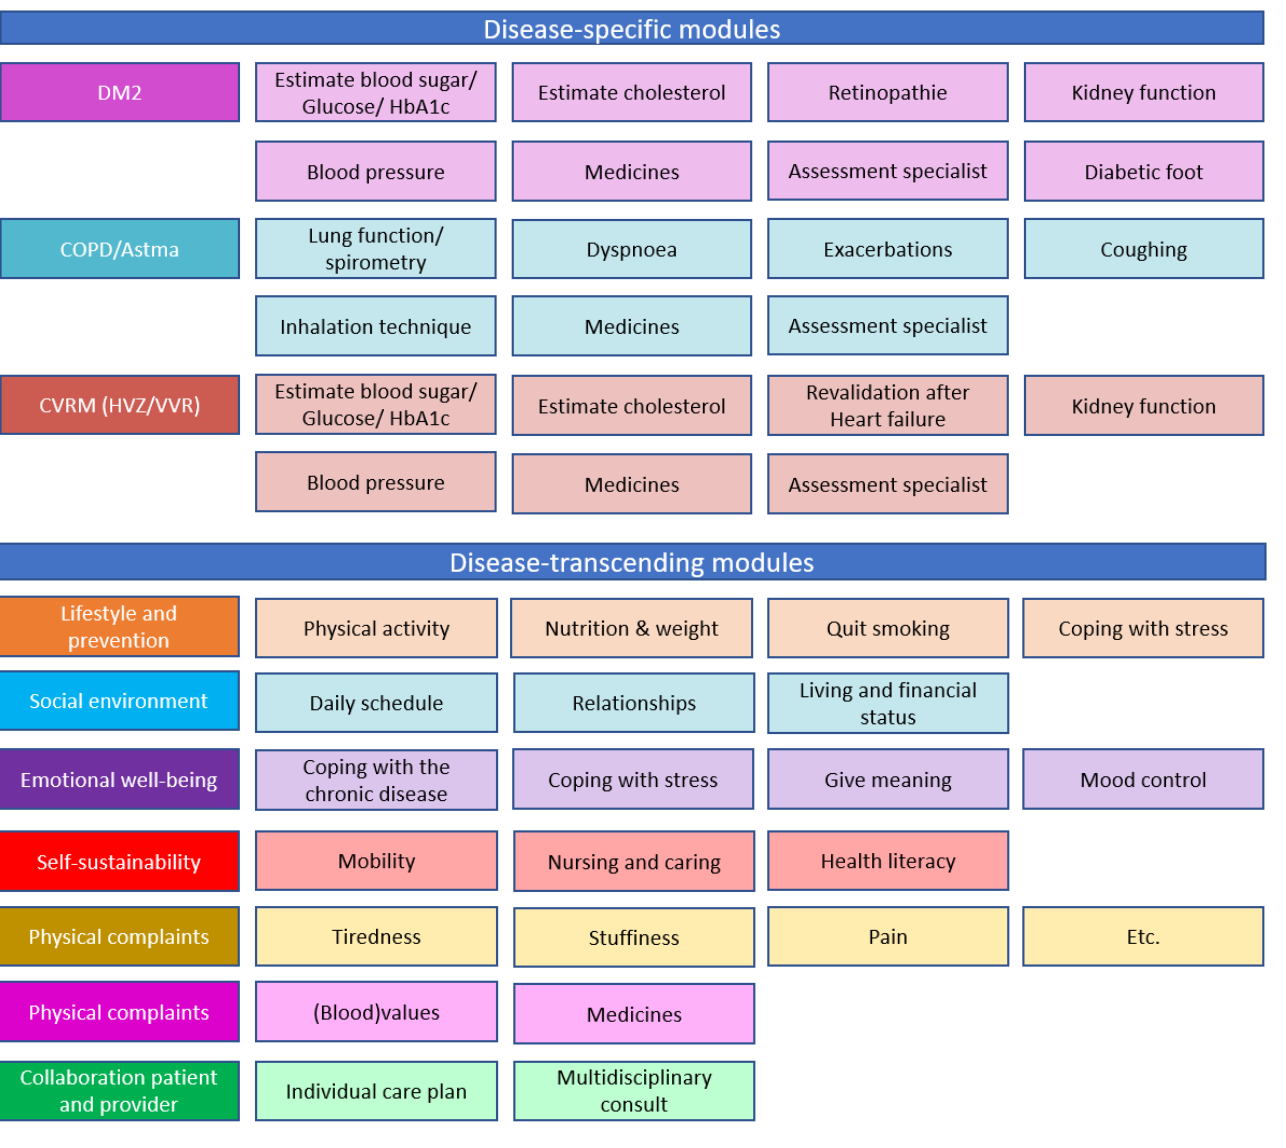
Table 3. Consequences which are generated by the proposed alternative payment model. Payment Model